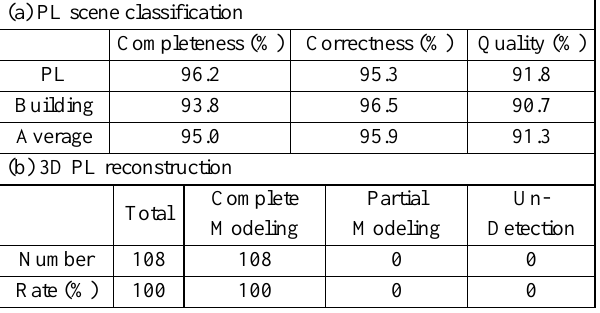
Table 1. Overall performance of the proposed method (a) PL scene